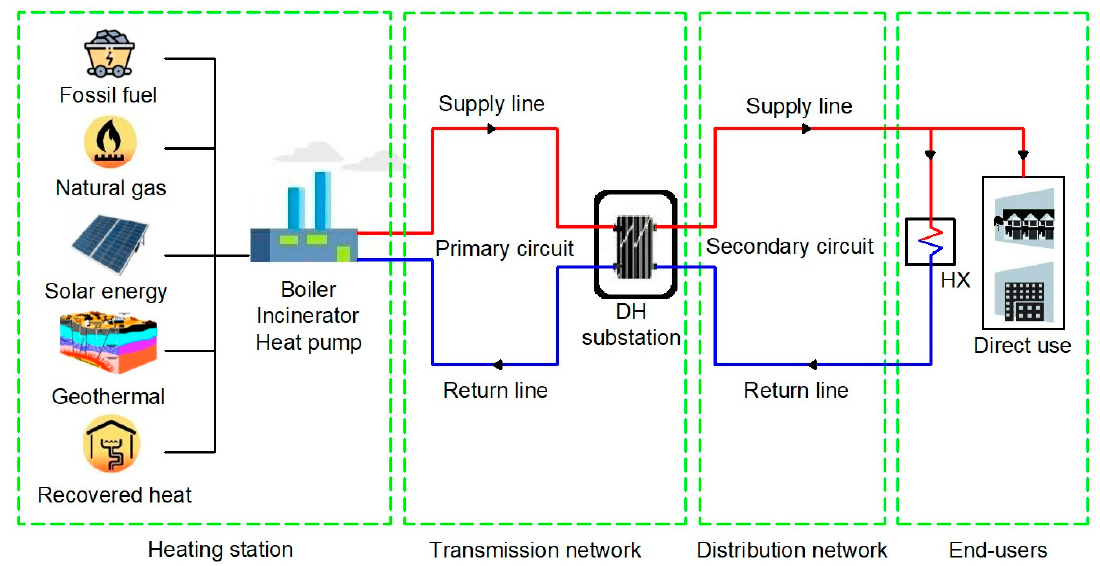
Figure 1. Essential district heating system components.